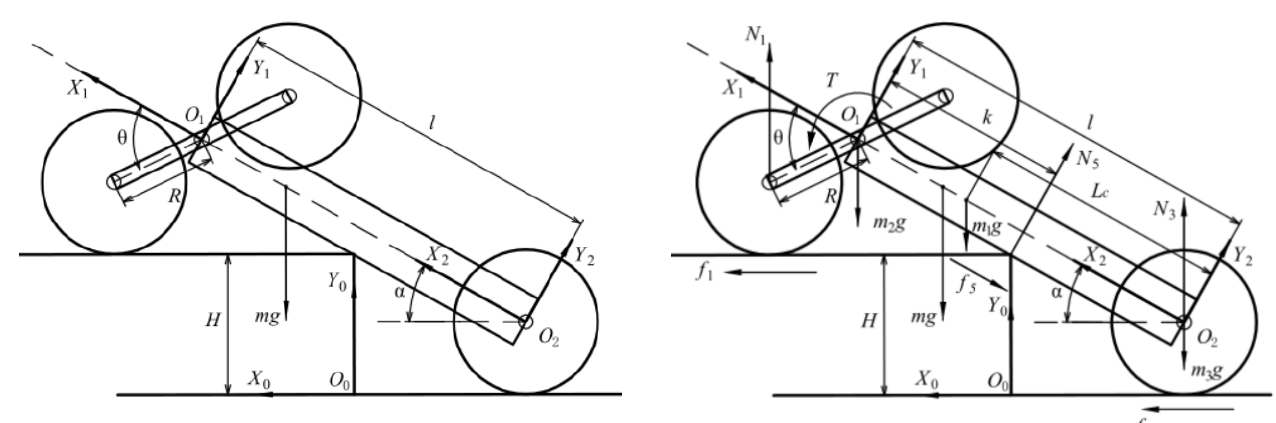
Figure 15. The geometric configuration of the robot in obstacle- crossing phase (d).